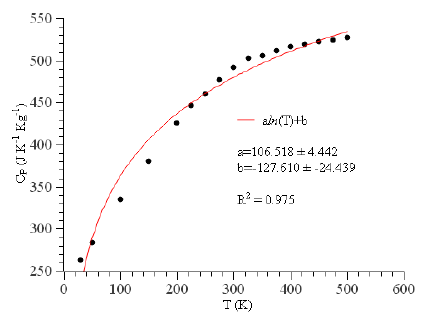
Figure 4. The specific heat follows reasonably well a logarithmic dependence on the temperature (data from